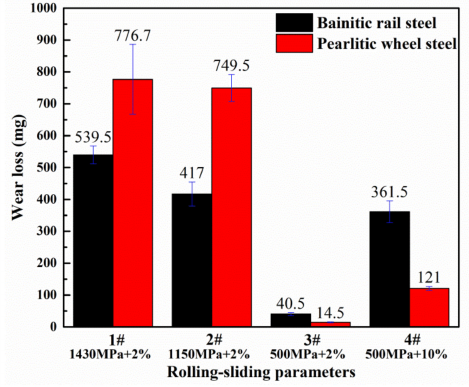
Figure 3. The wear loss of bainitic rail and pearlitic wheel